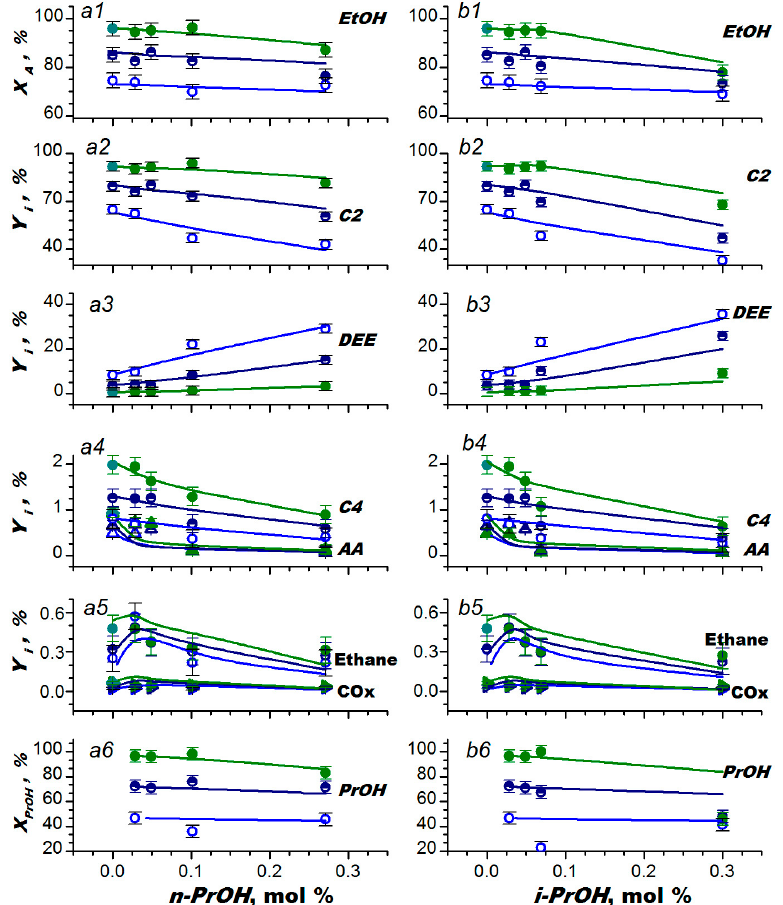
Figure 2. Effect of n-PrOH ( a1 – a6 ) and i-PrOH ( b1 – b6 ) impurity in 92% wt feedstock on ethanol X A and propanol X PrOH conversions, and products yield Y i at 350 (open), 370 (semi-open), and 400 ◦ C (solid). C2 , DEE , C4 , ethane (circle), AA , and COx (triangle). For conditions, see Figure 1. Symbols indicate experiments; lines indicate calculations for PFR using the extended kinetic model.